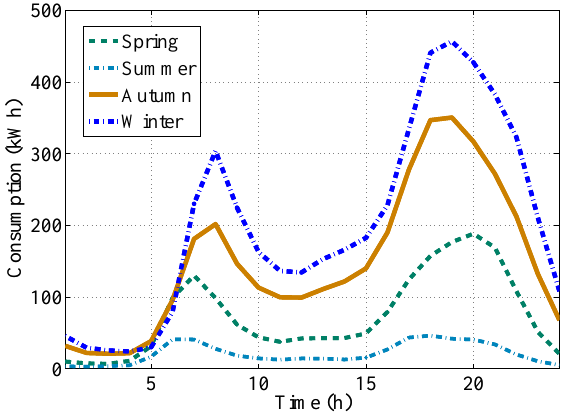
Figure 5. Seasonal mean hourly aggregated consumption of all